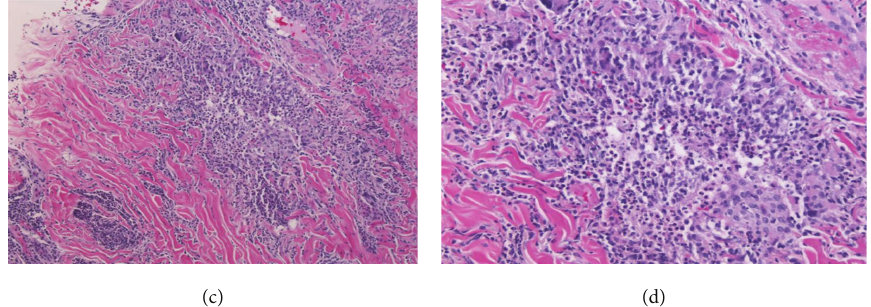
Figure 3: (c) (10x) and (d) (20x) Microgranulomas with suppurative necrosis. Small foci of tissue necrosis with acute inflammation, surrounded by histiocytes and multinucleated giant cells (arrows).